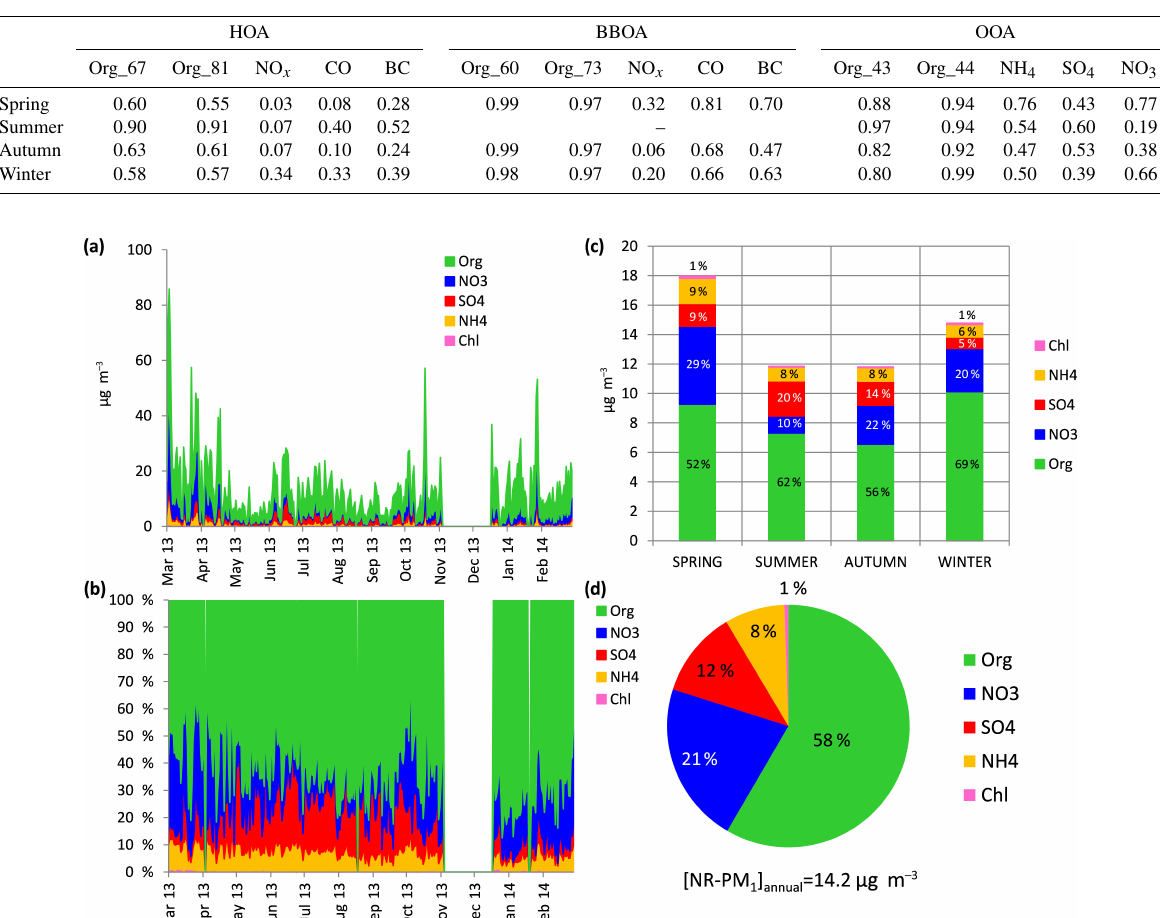
Table 2. Comparison (coefficient of determination, r 2 ) between SA factors, organic m/z tracers and independent species time series. BC stands for black carbon; Org_ i stands for organic signal at m/z i ( i = 43, 44, 60, 67, 73, 81).